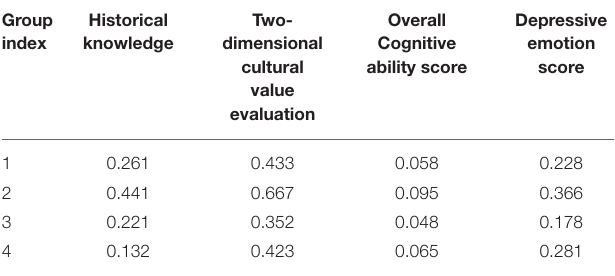
TABLE 1 | Cognitive level distribution table of left-behind